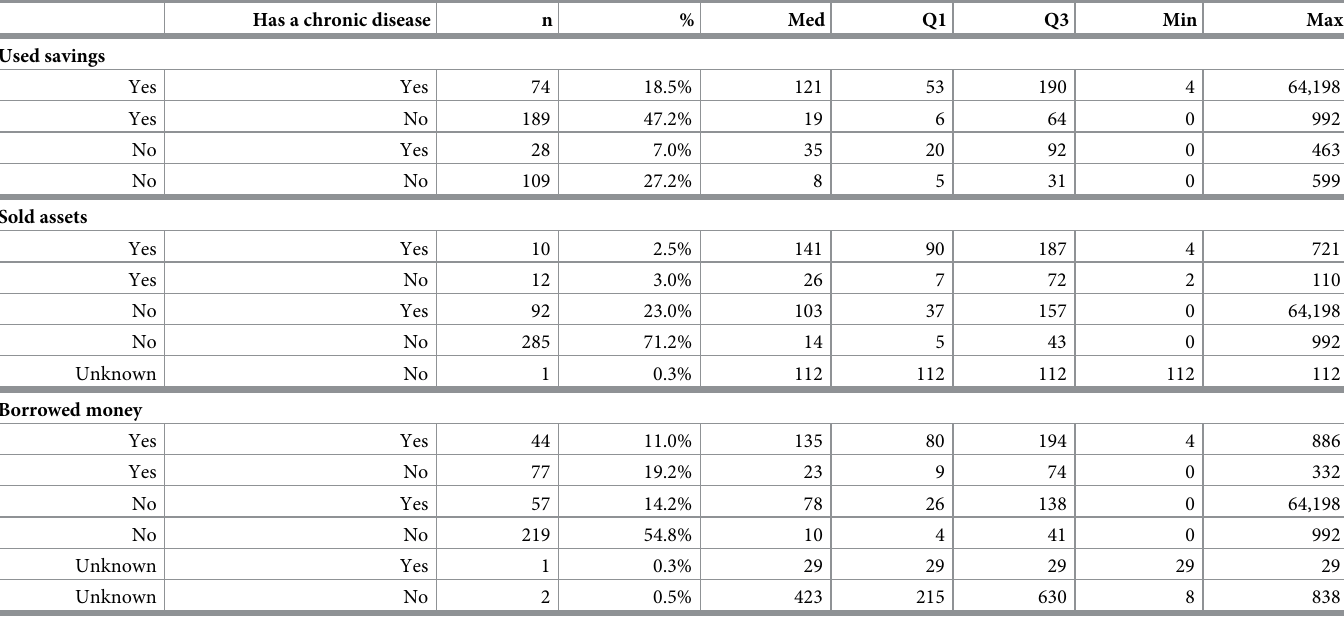
Table 5. Total costs of HIV and chronic disease care by indicators of financial distress (N = 400) (2019 USD). Has a chronic